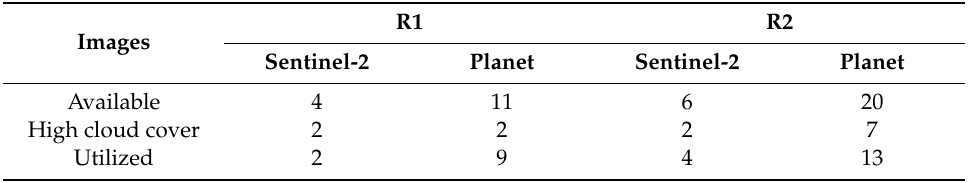
Table 1. Number of days with satellite images available, discarded due to high cloud cover and utilized in the study. Details provided for Sentinel-2 and Planet CubeSats for each regrowth period. R1 R2 Images Sentinel-2 Planet Sentinel-2 Planet Available 4 11 6 20 High cloud cover 2 2 2 7 Utilized 2 9 4 13 R1 : regrowth 1, R2 : regrowth